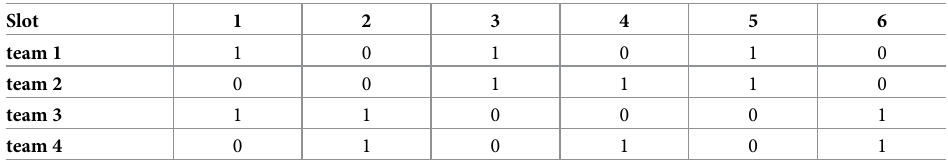
Table 2. Home away